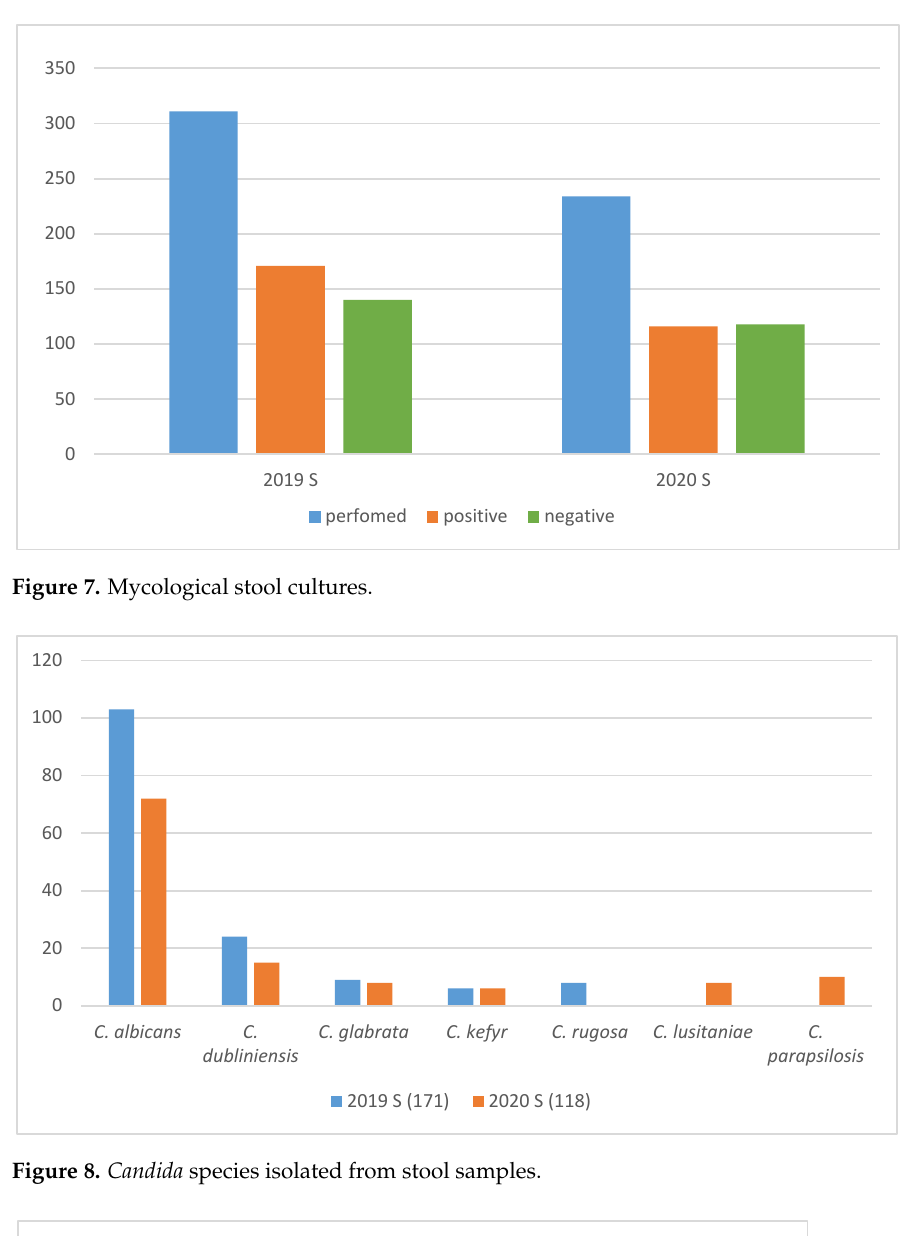
Figure 6. Stool cultures. Table 6. Mycological stool cultures.